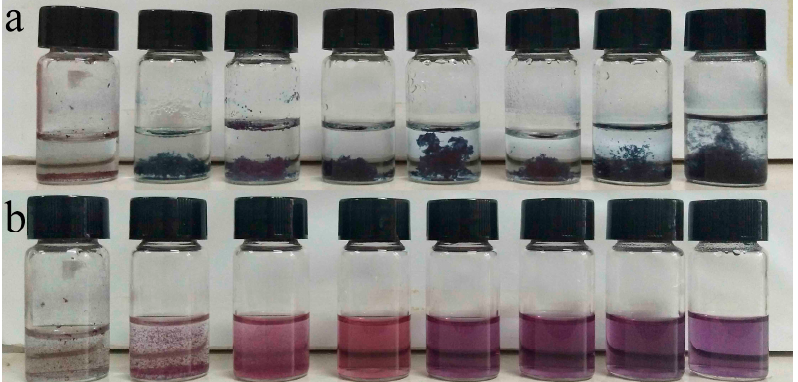
Figure 1. Digital images of PBI-R aggregates, r = 500:1, from left to right are water, p-toluenesulfonic acid, oxalic acid, malonic acid, citric acid, formic acid, glutaric acid and acetic acid. ( a ) PBI-1 and ( b ) PBI-2.